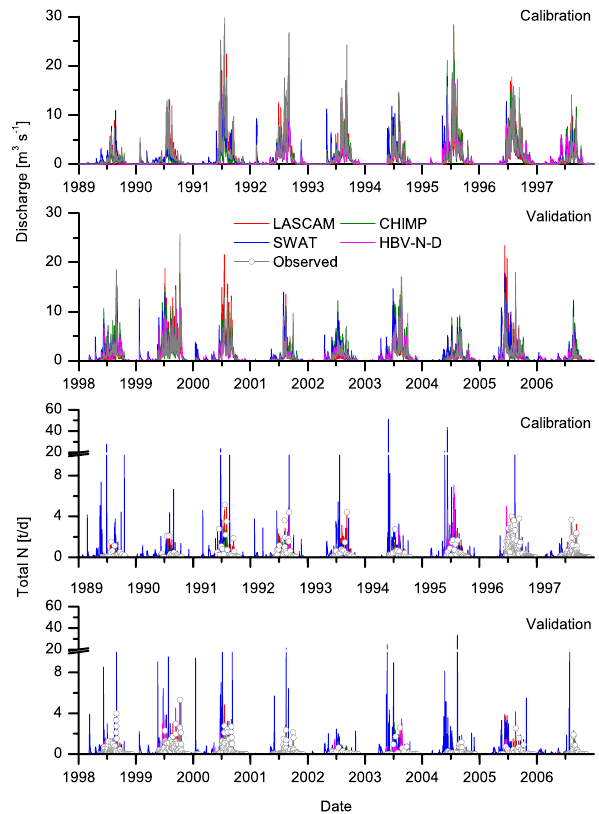
Fig. 2. Observed and predicted daily discharge and daily total N ex- port during calibration and validation periods for the model cohort.